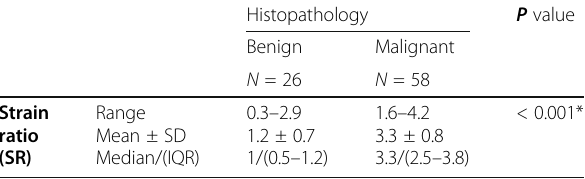
Table 3 Relation between elastographic strain ratio and final histopathological